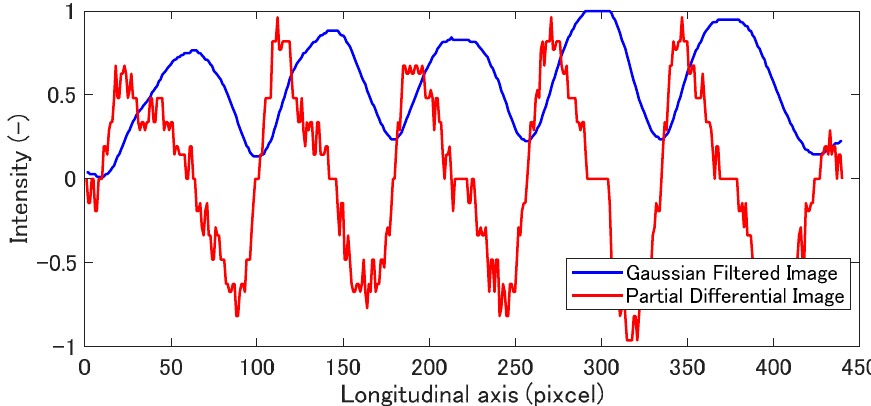
Figure 4. Intensity distribution in the direction x .